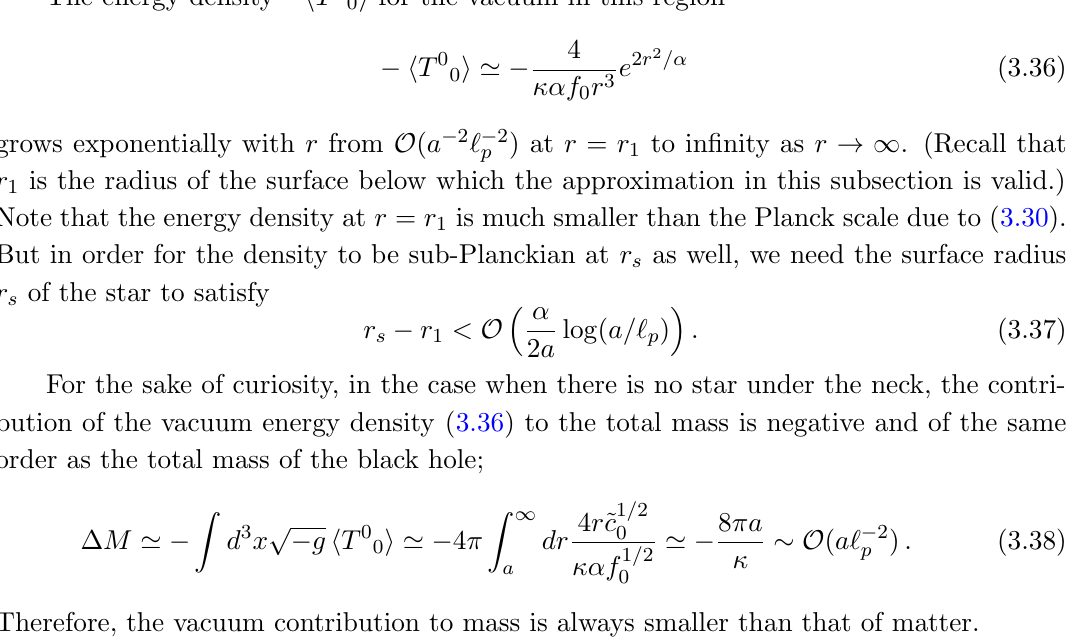
Figure 1 . The schematical cross section of a black hole around the neck, assuming that the surface of the star is under the neck (not shown). The radius r has a local minimum at the quantum Schwarzschild radius a , and increases to in(cid:12)nity within a proper distance of order is impossible to faithfully present the geometry through an embedding in (cid:13)at 3D space. The graph presents the change in the radius r , while the proper distance is represented by the projection on the vertical